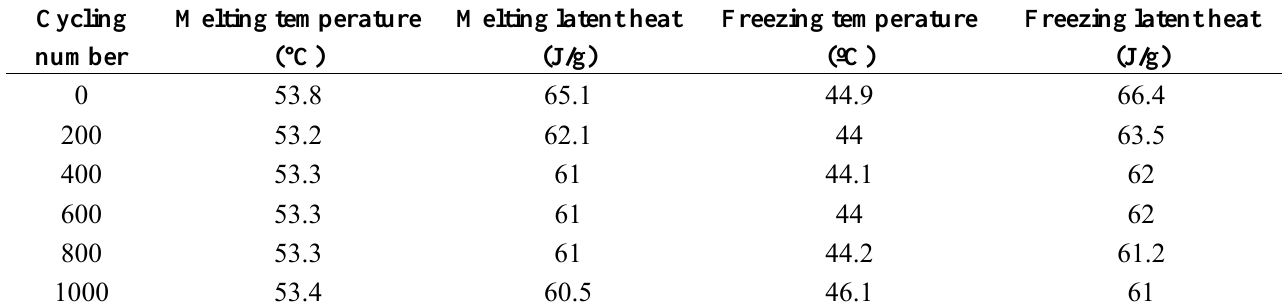
Table 2. DSC result of the microencapsulated paraffin wax,